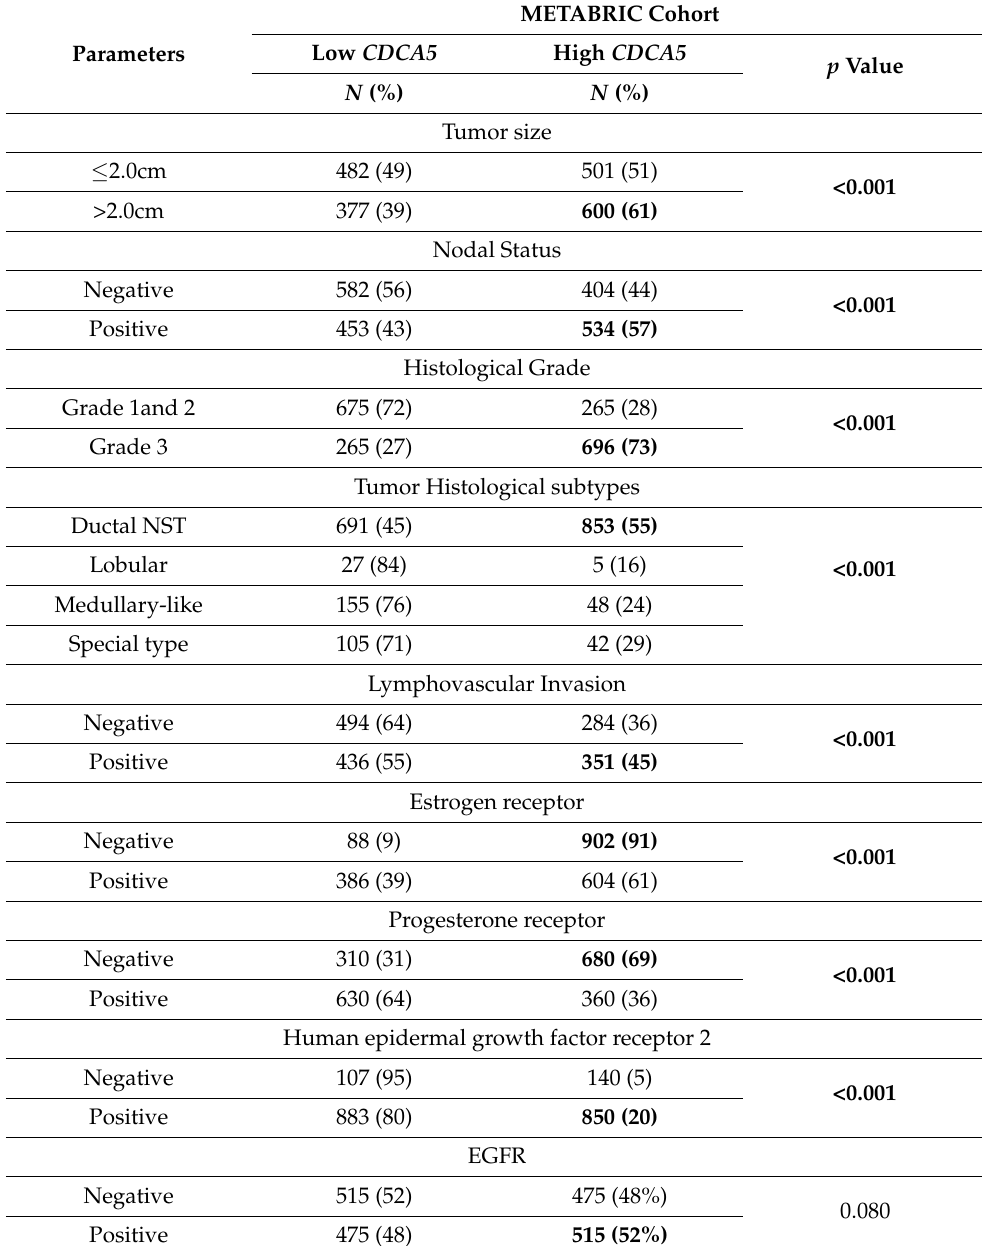
Table 1. Association of CDCA5 mRNA expression with clinicopathological characteristics in the METABRIC ( n =